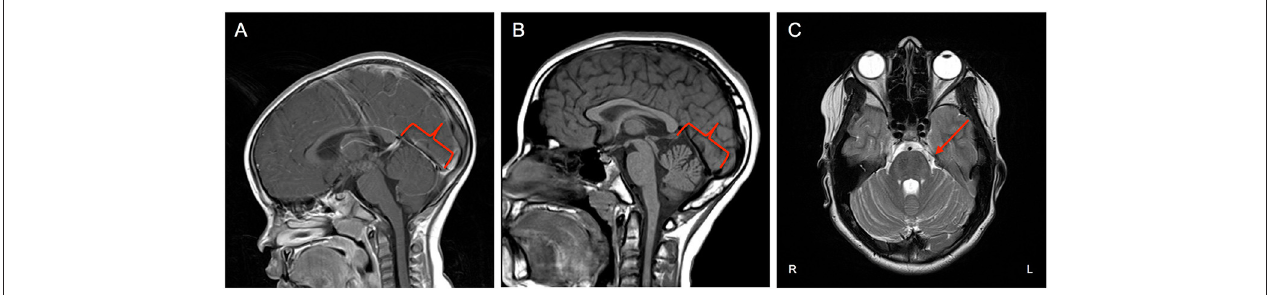
FIGURE 1 | (A) Midsagittal MRI at age 3 showing no cerebellar changes at that time. (B) Midsagittal MRI at age 11 showing evidence of asymmetric volume loss within the superior and middle components of the cerebellar vermis with preserved volume of the inferior component (red outline). (C) Axial plane MRI exhibiting faint linear/T2 signal hypointensities within the Pons (red